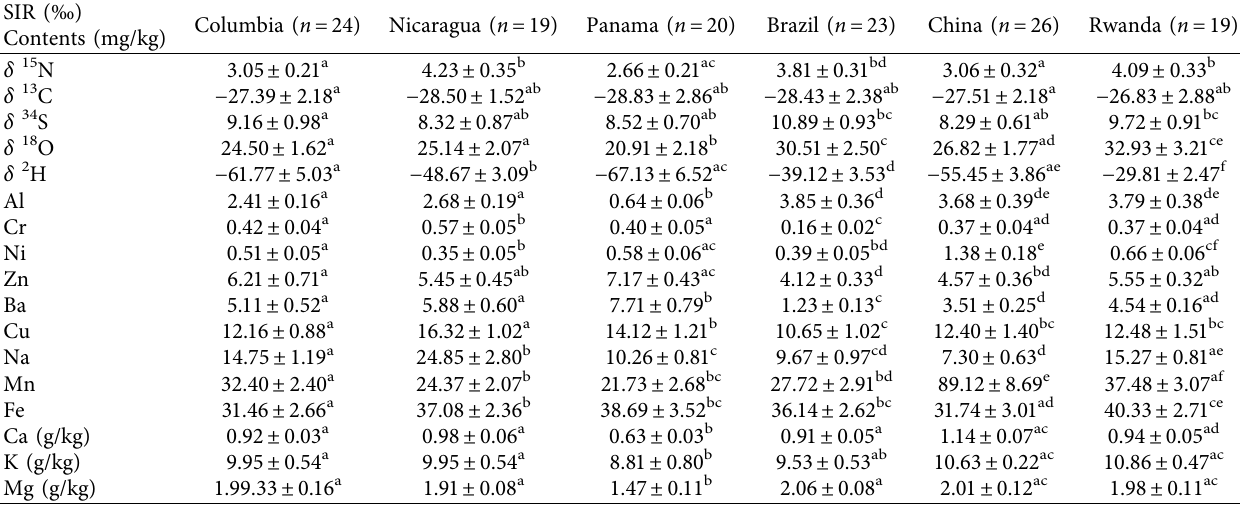
Table 6: Te mean ± standard error value of fve stable isotopes and twelve elements of middle roasted beans from six diferent origins. SIR